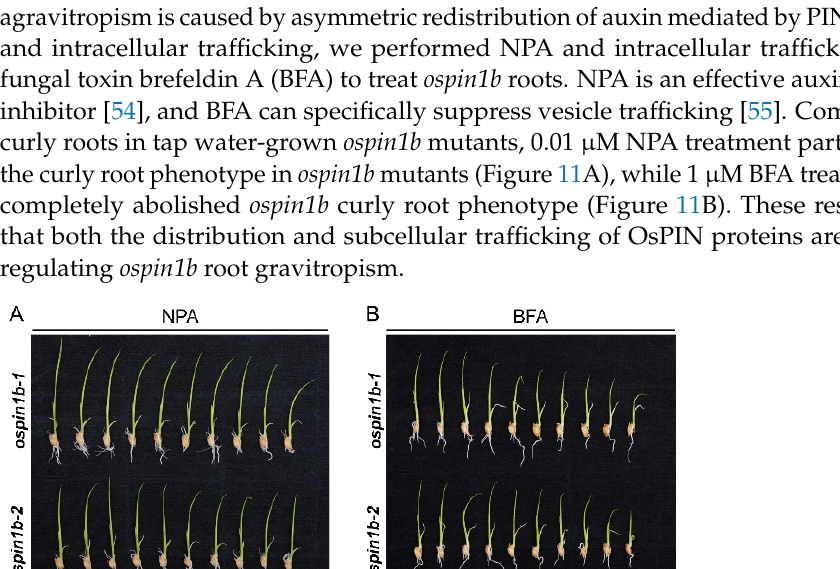
Figure 11. NPA and BFA treatment substantially rescued ospin1b curly root phenotype. ( A ) 0.01 μ M NPA treatment. ( B ) 1 μ M BFA treatment. Bar = 2 cm.